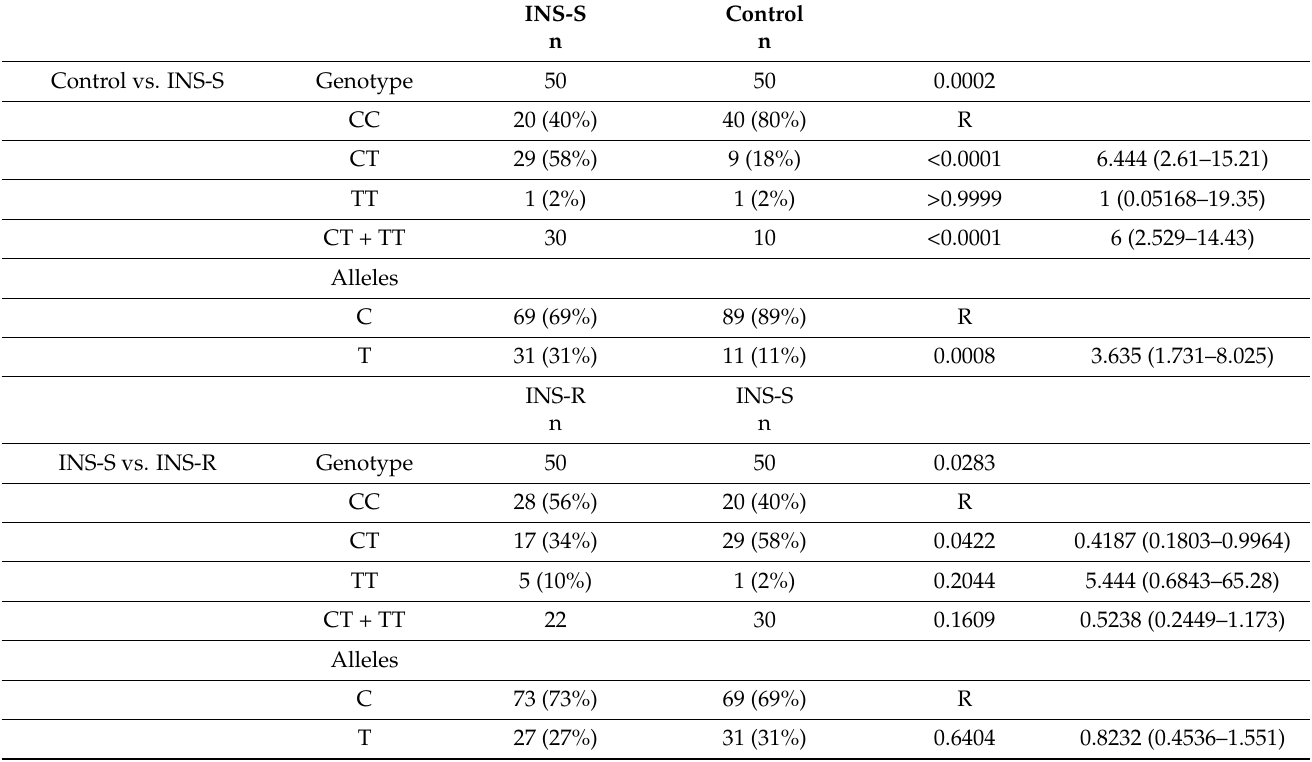
Table 3. Genotype distributions and allele frequencies of SNP rs3200401 in MALAT1 gene in con- trol vs. INS-S and INS-S vs. INS-R